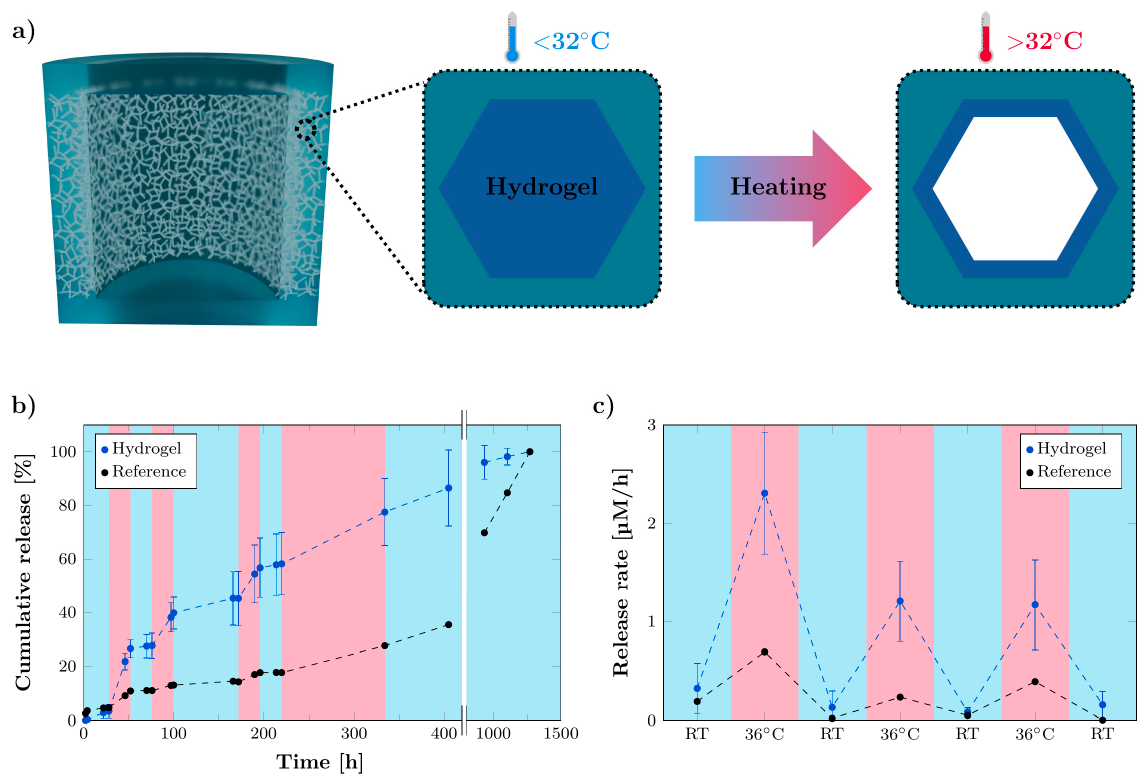
Figure 9. The functionalization of microchannels by thermo-responsive hydrogel for temperature- responsive release. ( a ) Schematic of the rDDS with thermo-responsive hydrogel inside the micro- channels. The hydrogel shrinks upon heating above the lower critical solution temperature of 32 °C. ( b ) Cumulative release of methylene blue from hydrogel-containing rDDS, as well as a reference, during multiple heating steps to 36 °C and subsequent cooling to RT. ( c ) Release rates of hydrogel- containing rDDS, as well as the reference, as determined from the cumulative release curve for the respective heating and cooling steps. Data points of hydrogel-containing rDDS are averages ( n = 3), and error bars represent the standard deviation.